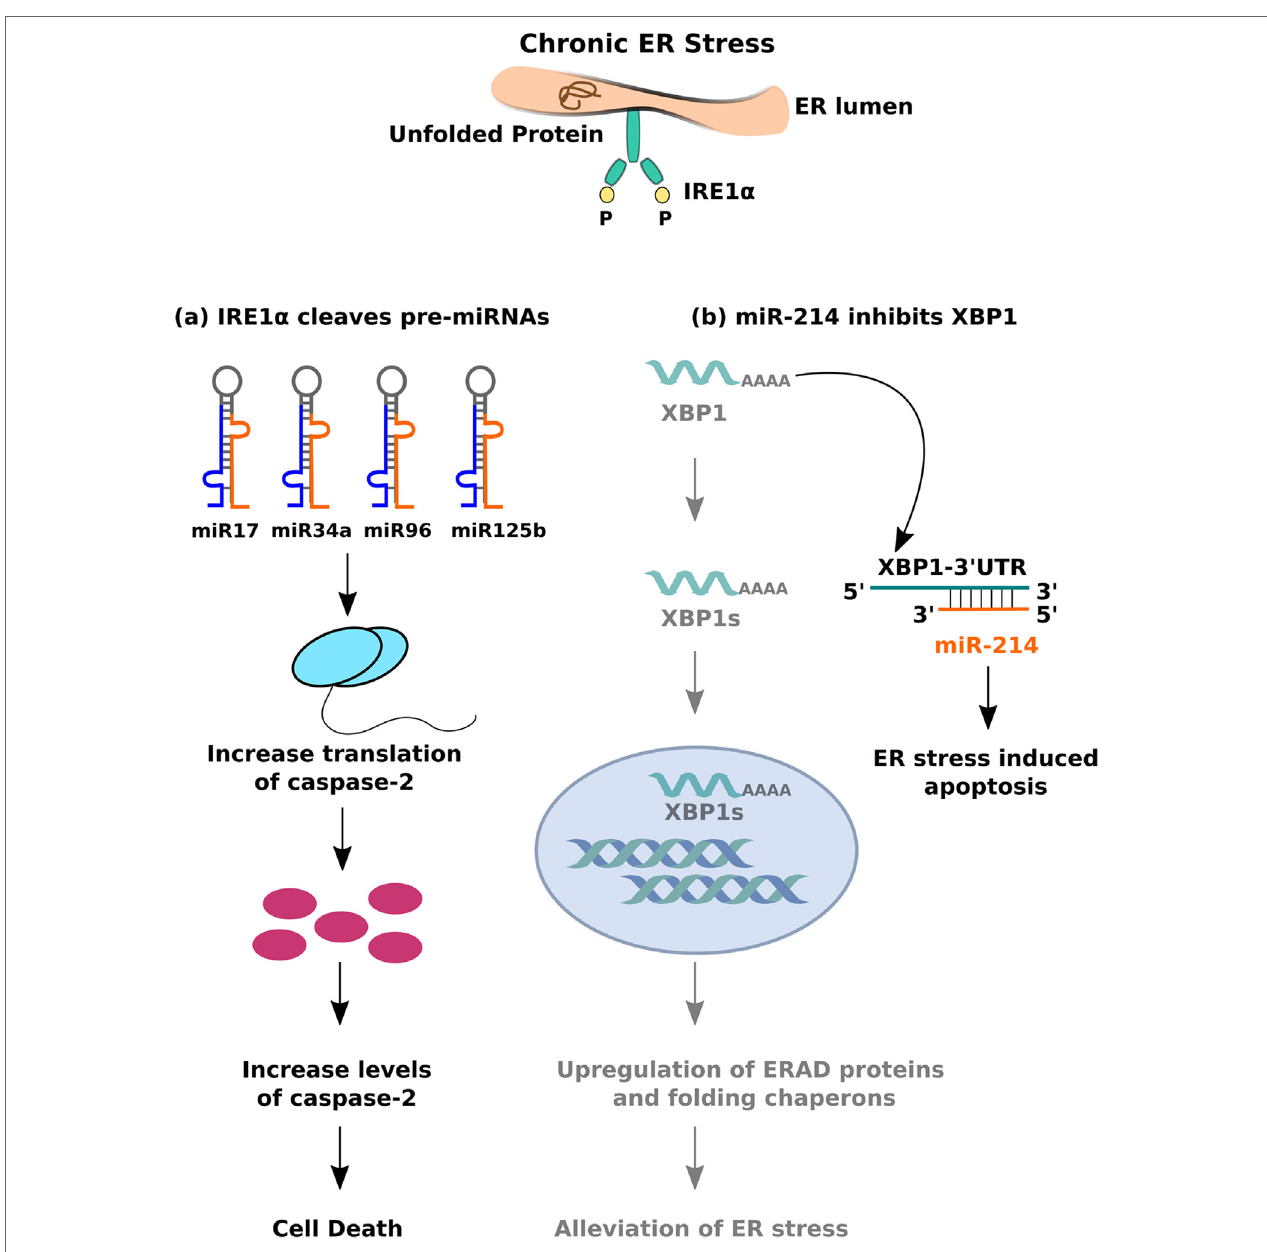
FigURe 4 | Crosstalk between miRNA and inositol-requiring 1 α signalling. (A) The endoribonuclease activity of IRE1 α cleaves set of pre-miRNAs (miR-17, miR-34a, miR-96, and miR0125b) leading to decreased expression of mature miRNAs, thereby resulting in caspase-2 upregulation and eventual cell death. (B) miR-214 binds to 3 ′ -UTR (untranslated region) of XBP-1, leading to mRNA downregulation, and inhibition of IRE1 α mediated adaptive unfolded protein response (UPR)